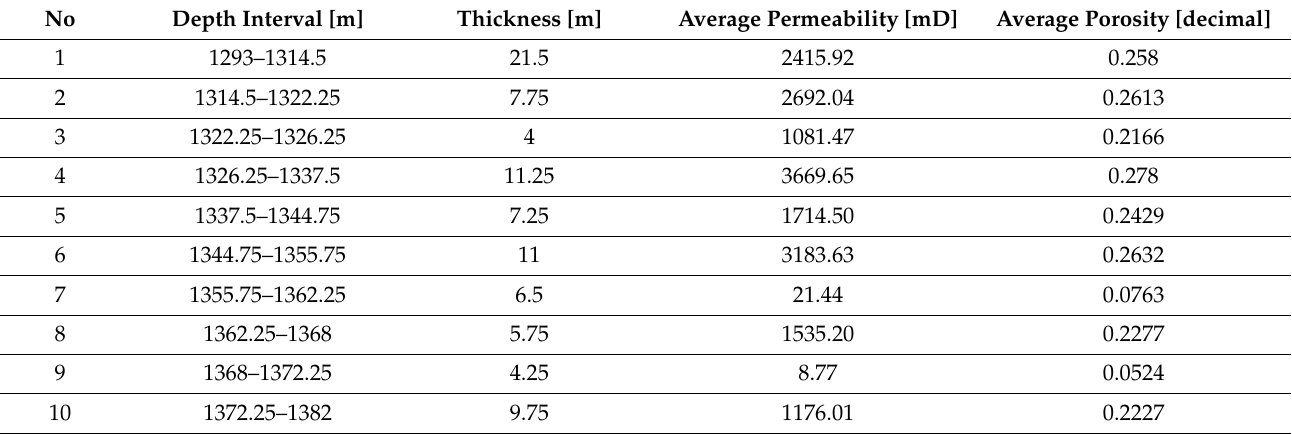
Table 4. Characteristics of the ten separate reservoir layers within the Komorowo Lower Jurassic Formation of the Suliszewo structure in the Suliszewo 1